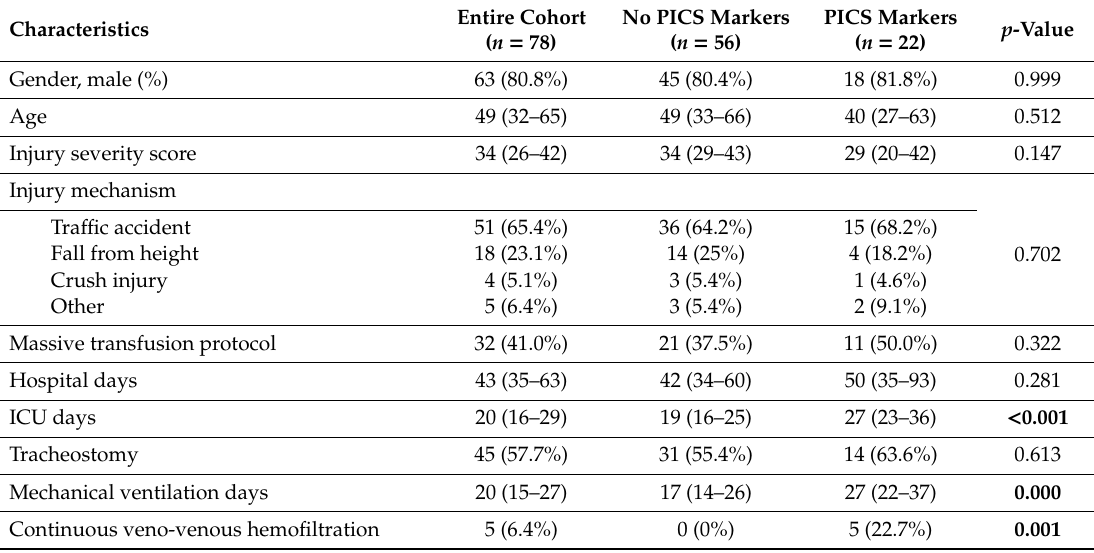
Table 2. Characteristics of CCI patients with positive PICS markers vs. other CCI